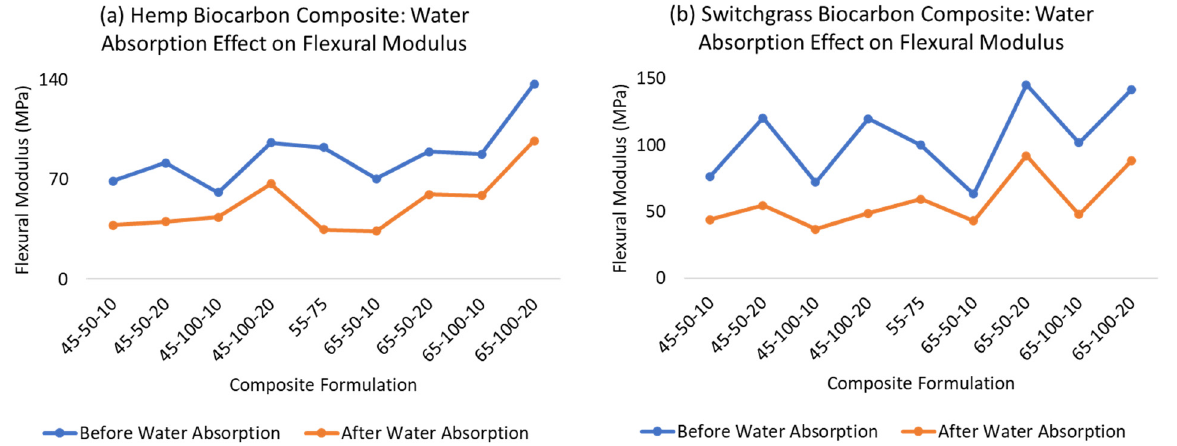
Figure 11. Difference in mean flexural moduli of biocarbon-filled hemp composite due to water absorption.